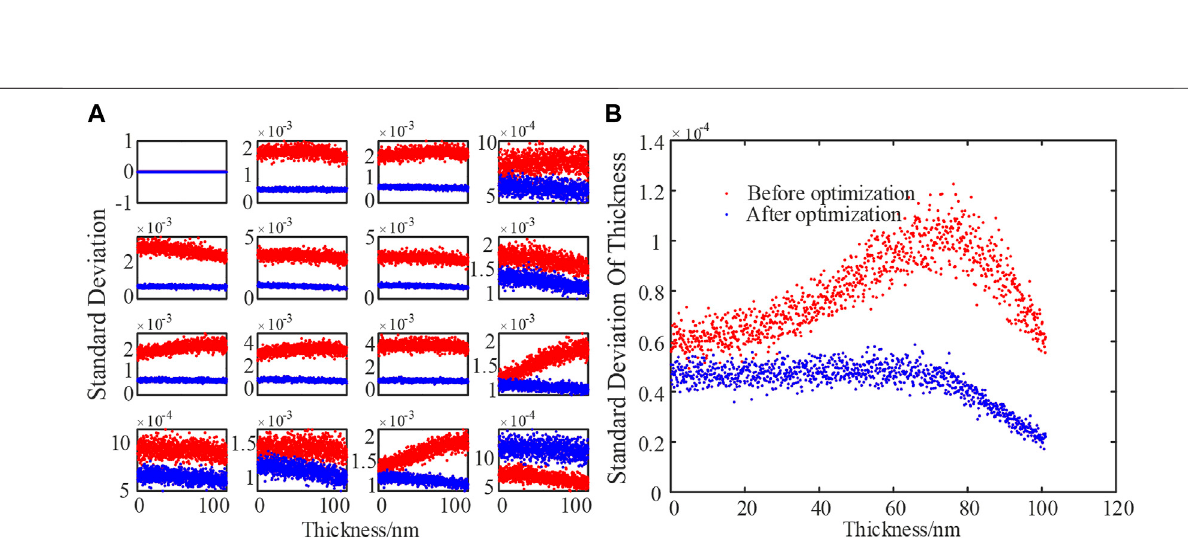
Frontiers in Physics |